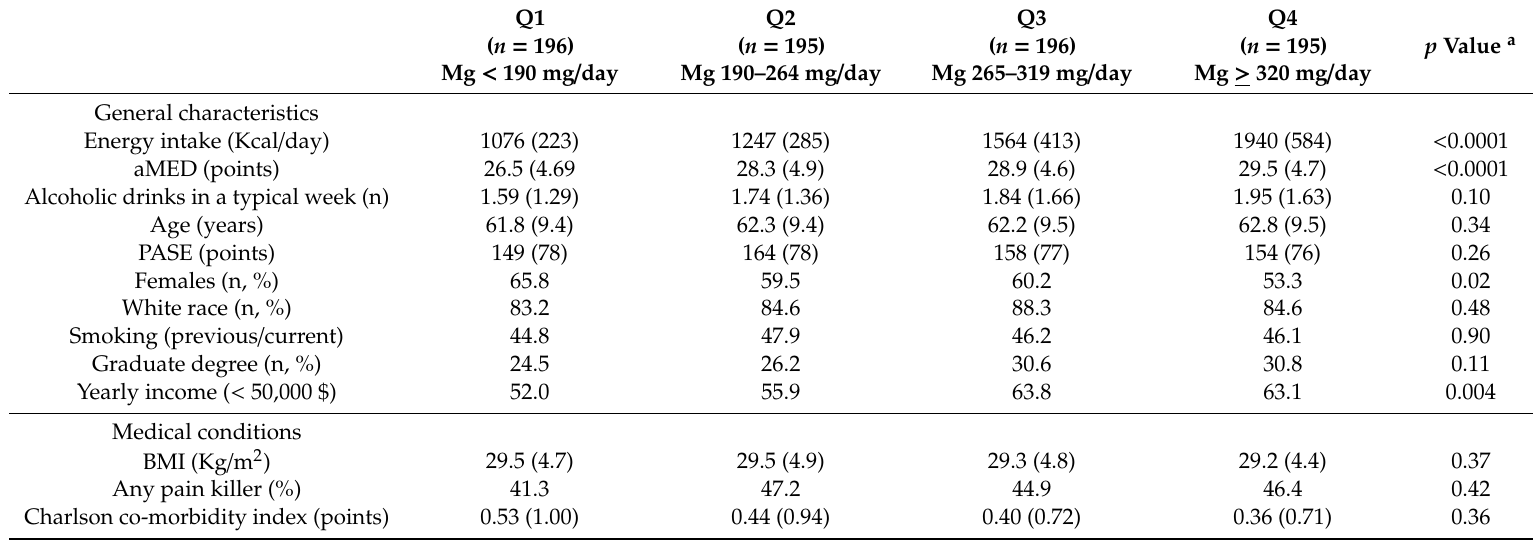
Table 1. Descriptive findings of the participants by total dietary magnesium